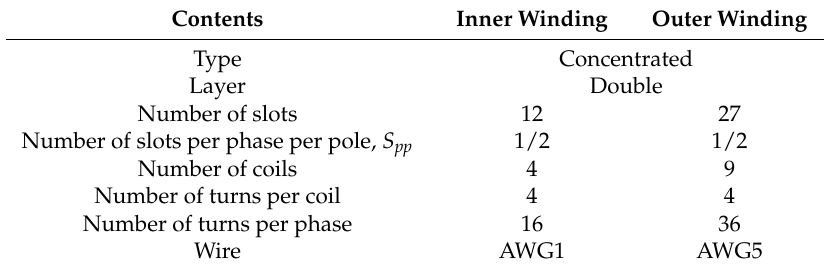
Table 2. Specifications of the winding